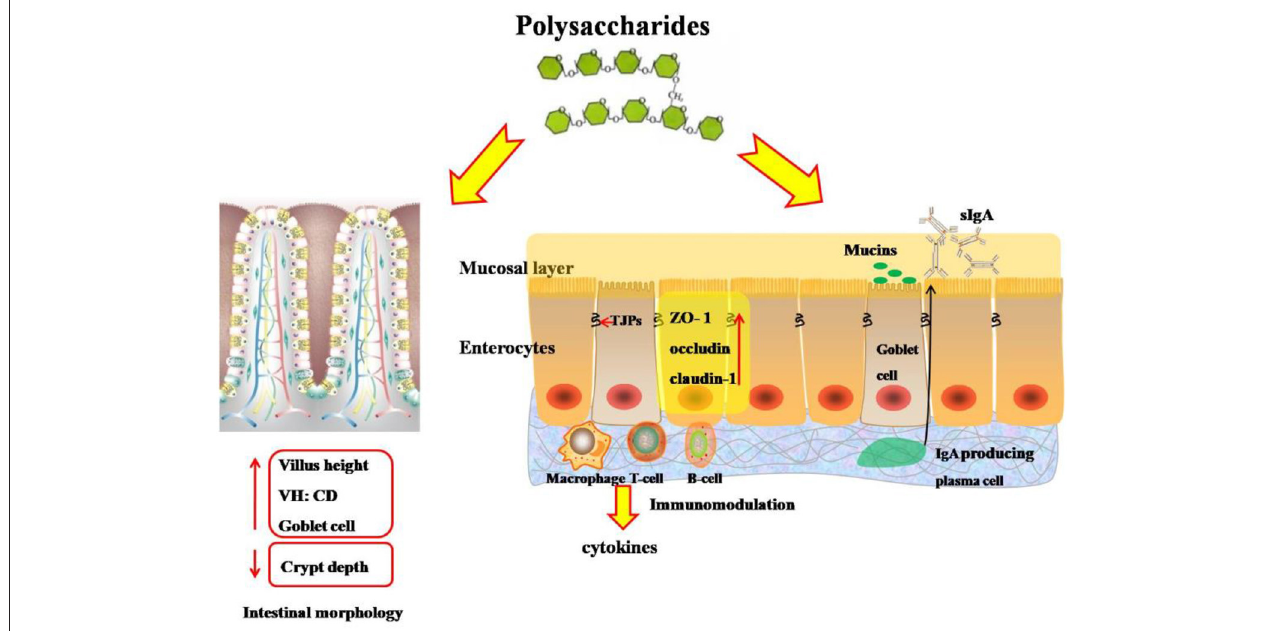
FIGURE 2 | Effects of polysaccharides on intestinal morphology and intestinal mucosal immunity and barrier integrity of broilers. VH:CD, the ratio of villus height to crypt depth; TJPs, tight junction proteins; ZO-1, zonula-1; T-cell, T lymphocyte; B-cell, B lymphocyte; IgA, immunological A; sIgA, secretory immunological